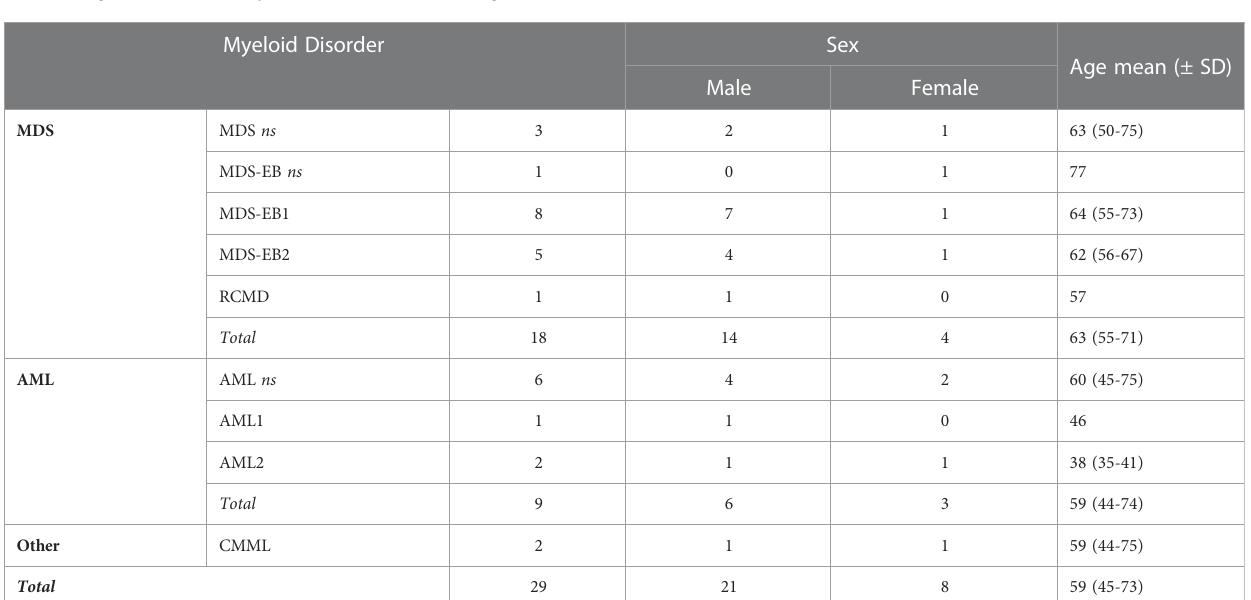
TABLE 1 Myeloid disorders of patients included in the